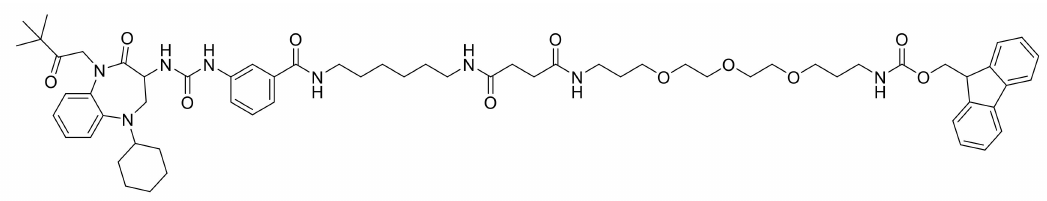
Figure 11. Chemical structure of 6